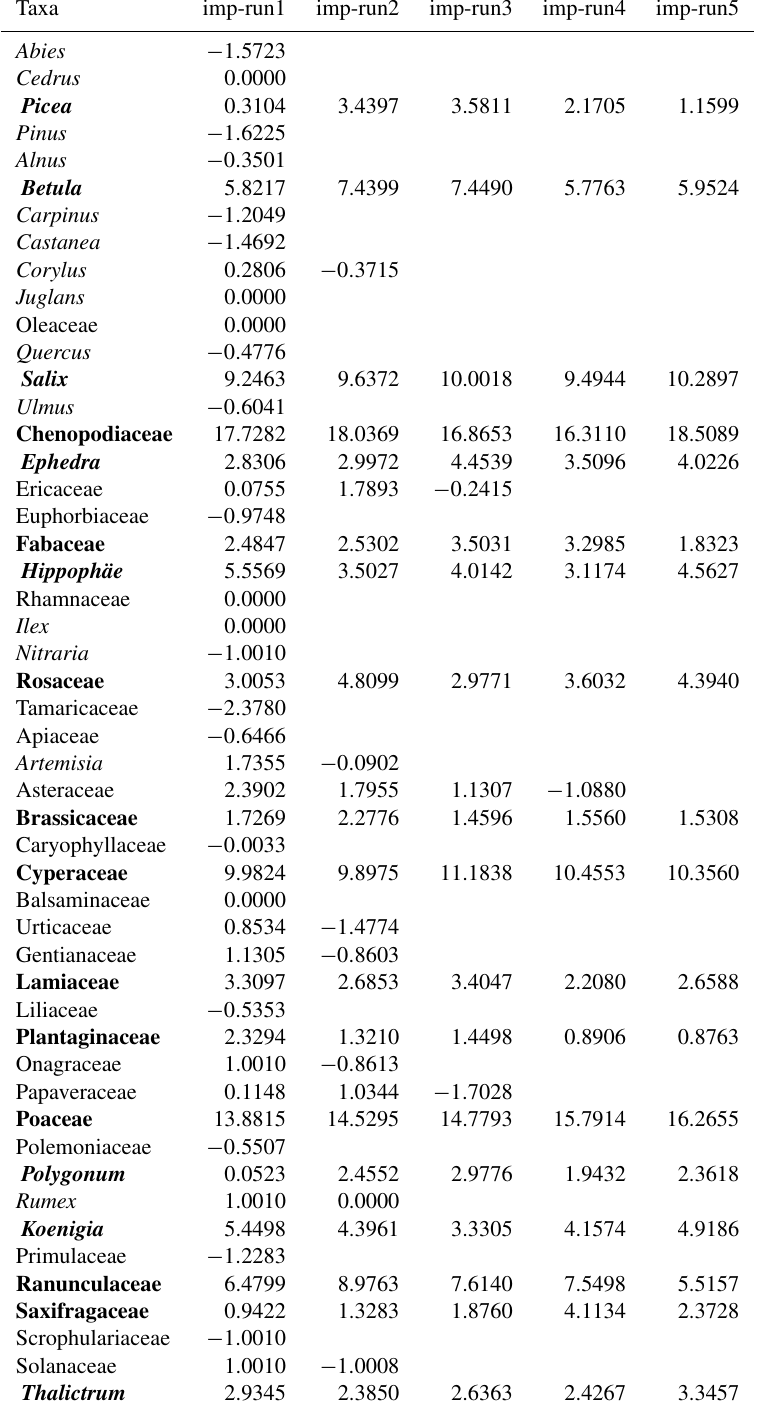
Table B1. Importance (imp) of pollen taxa on the spatial distribution of P ann was repeatedly assessed by the random forest algorithm (RF). Shown in bold are the pollen taxa selected for the P ann reconstruction based on